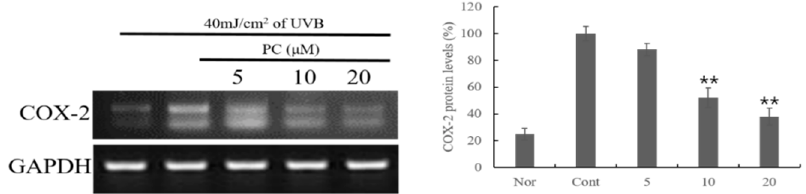
Figure 3. Effect of PC ( 1 ) treatment on COX-2 mRNA expression in HaCaT cells. HaCaT cells were treated with different concentrations of PC ( 1 ) for 1 h. The cells were further stimulated with 40 mJ/cm 2 UVB. After 24 h, the cells were harvested, and relative mRNA levels were determined. Histograms show the densitometric data of COX-2 mRNA normalized to GAPDH. Each value represents the mean ± SD of three individual experiments. Nor: Non-treated cell group (0 h), Cont: 40 mJ/cm 2 UVB-treated cell group. Data are expressed as the means ± S.D., n = 3. ** p < 0.0001 compared to the control group.